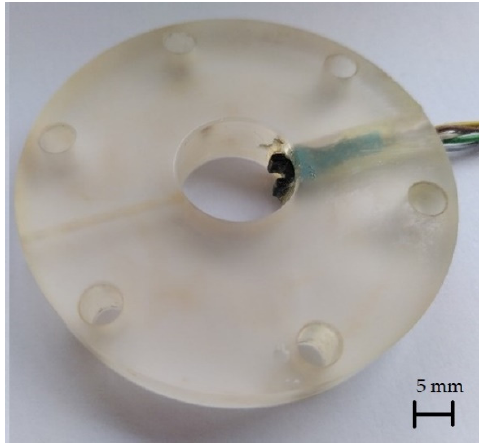
Figure 11. Individual disc module of the decanter with glued-in TCUT optical sensor for level control.